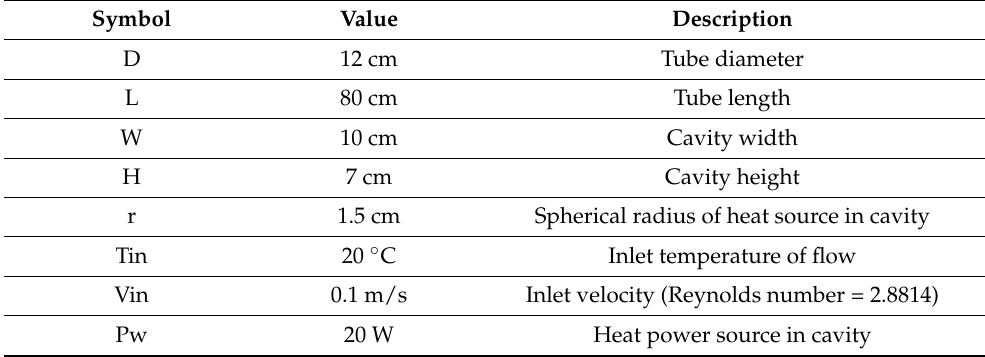
Figure 1. Schematic diagram of physical systems with geometric dimensions. Table 1. Geometrical specifications and flow